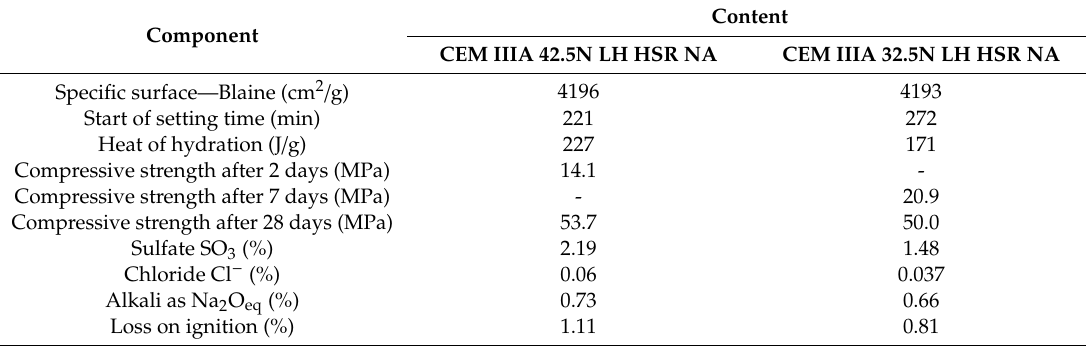
Table 2. Physical, mechanical, and selected chemical parameters of cements.